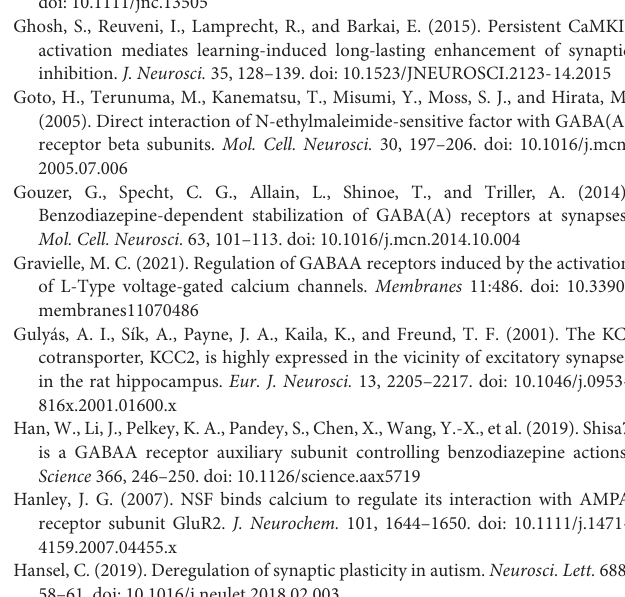
Figueroa, A. G., Benkwitz, C., Surges, G., Kunz, N., Homanics, G. E., and Pearce, R. A. (2021). Hippocampal β 2-GABAA receptors mediate LTP suppression by etomidate and contribute to long-lasting feedback but not feedforward inhibition of pyramidal neurons. J. Neurophysiol. 126, 1090–1100. doi: